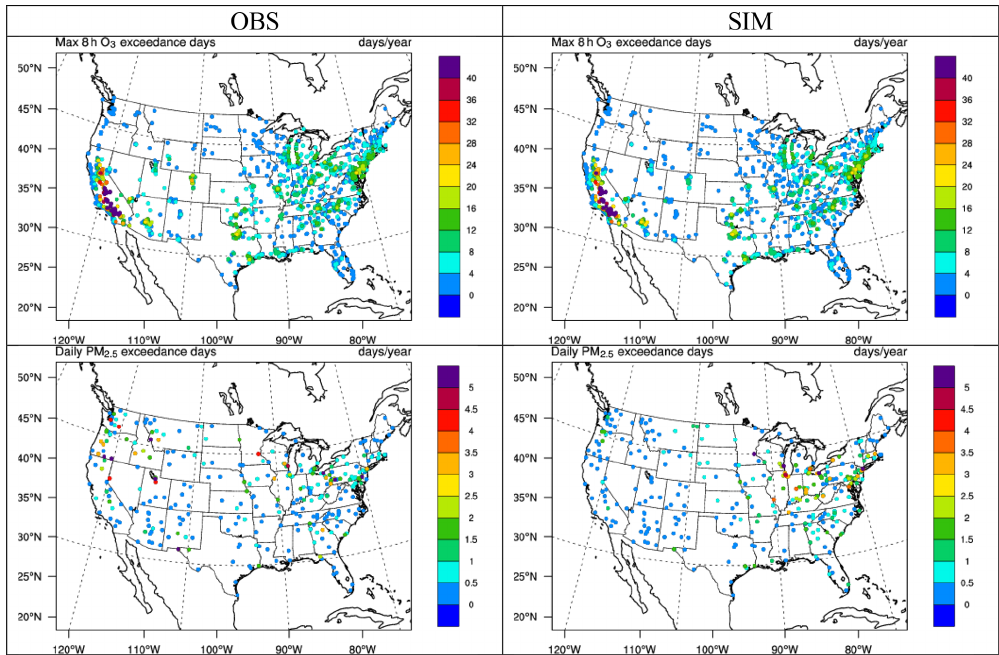
Figure 14. The spatial distribution of 5-year average annual exceedance days of max 8h O 3 and daily PM 2 . 5 between observations (O 3 over the AIRS-AQS/CASTNET network and PM 2 . 5 over the IMPROVE/CSN network) and two-way WRF-CMAQ in 2008–2012.